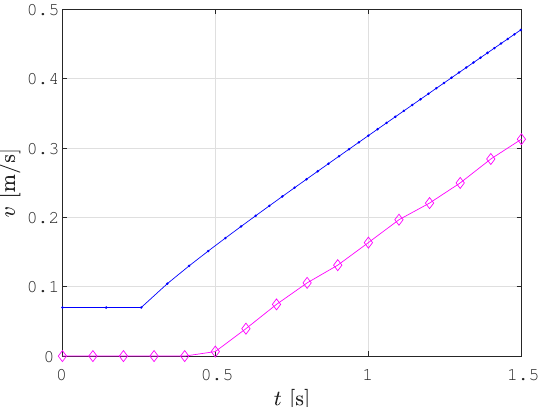
Figure 16. Calculated linear and angular velocities (blue line) and linear and angular velocities, while the Pioneer 3DX robot is tracking the trajectory (magenta line).